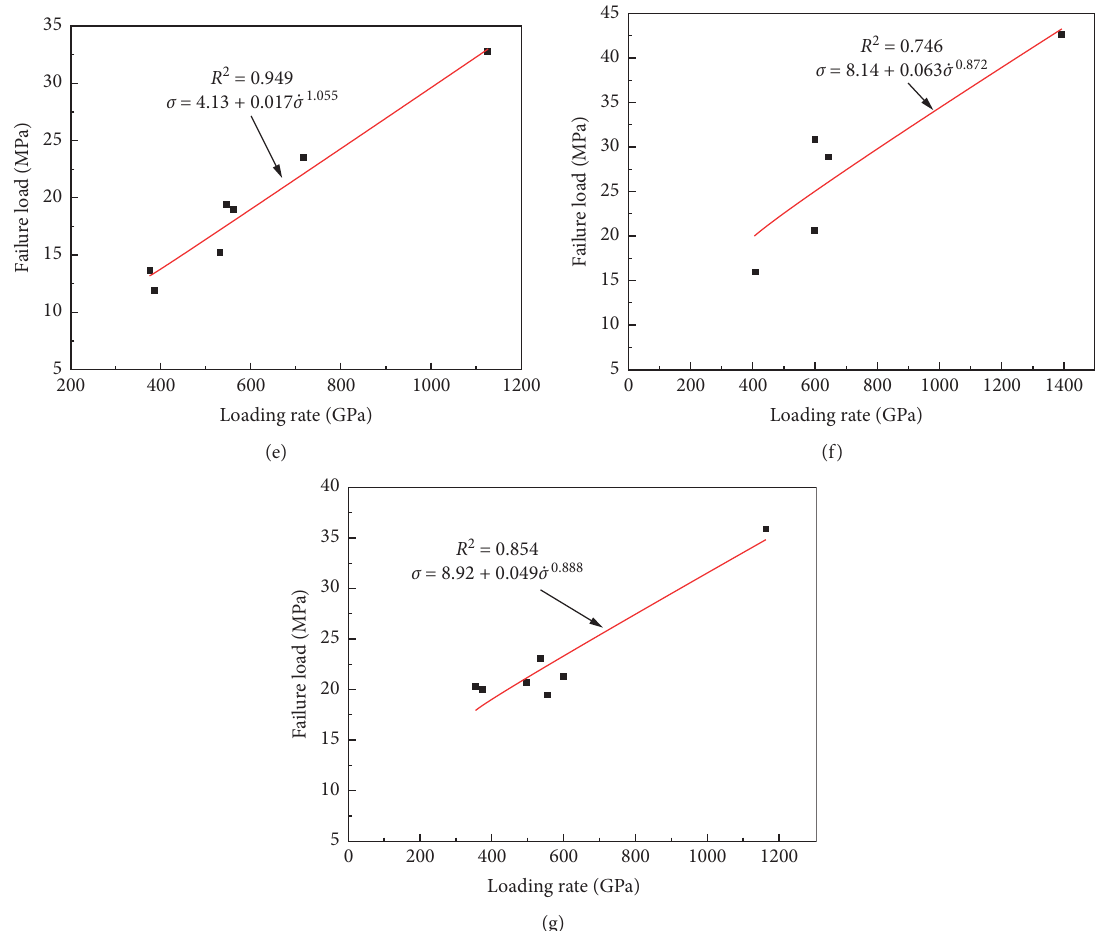
Figure 7: The relationship between the dynamic failure load and the loading rate. (a–g) The inclination angles of 0 ° , 15 ° , 30 ° , 45 ° , 60 ° , 75 ° , and 90 ° ,